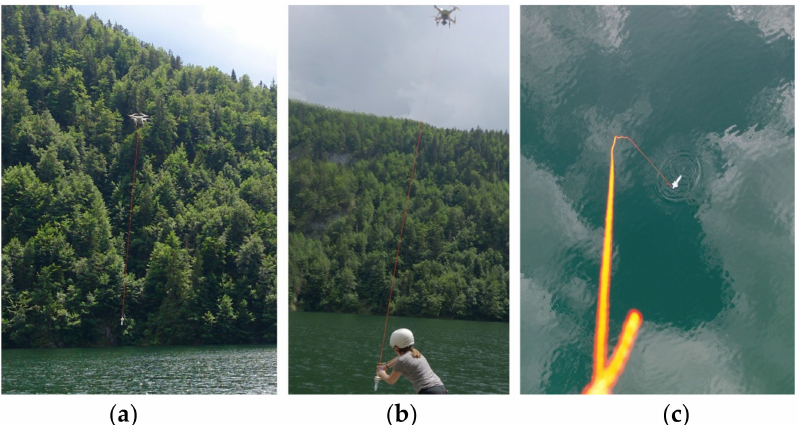
Figure 2. ( a ) The DrOne Water Sampling SystEm (DOWSE) preparing to collect a sample at Toplitzsee (TOP) in Austria; ( b ) The DOWSE returning from a sampling mission at TOP; ( c ) Overhead image of the sampling device in the water taken from the quadcopter. This provided a precise record of the location and sampling time which was embedded in the Exif file of each of the